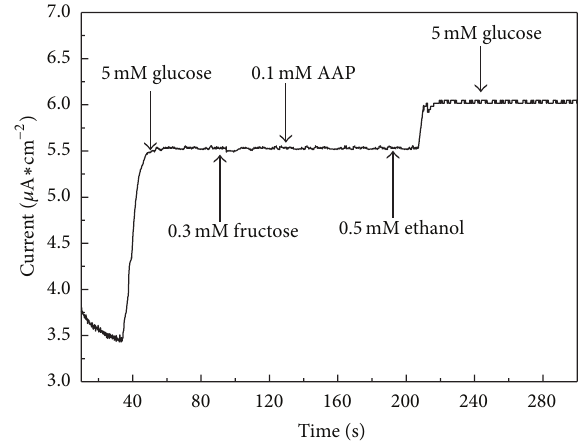
Figure 4: CVs of Ag-TiO 2 (500 ∘ C) nanotube electrode in 0.5 M glucose supported by 0.1 M neutral PBS, 0.1M H 2 SO 4 , and 0.1M NaOH.